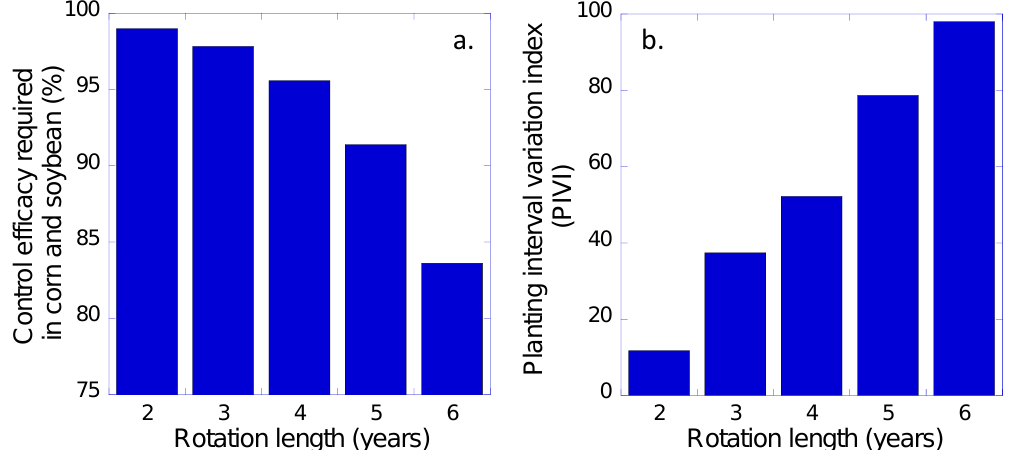
Figure 3. Minimum levels of control efficacy required in corn and soybean to prevent increases in giant ragweed seed densities ( a ), and planting interval variance index values (PIVI) ( b ) for the 2-, 3-, 4-, 5-, and 6-year rotation systems.